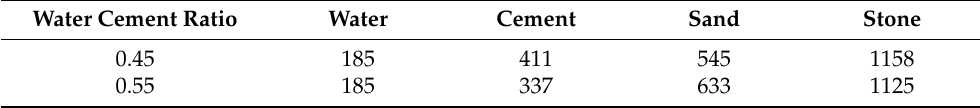
Table 1. Mixture proportions of concrete (kg/m 3